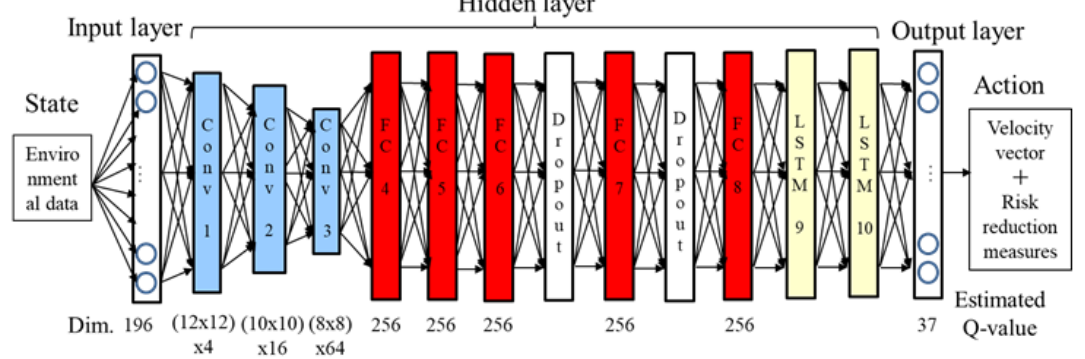
Figure 2. Deep Q-network model for learning fall risk reduction measures.